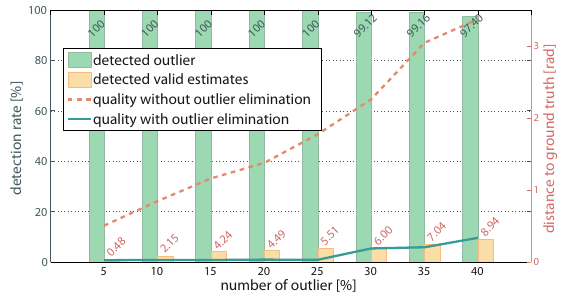
Figure 4: Outlier detection for various rates of outliers in the relative rotations, true positives (green bars) and false positives (orange bars). The curves show the accumulated distance of all estimated rotation matrices to their ground truth with and without outlier elimination.